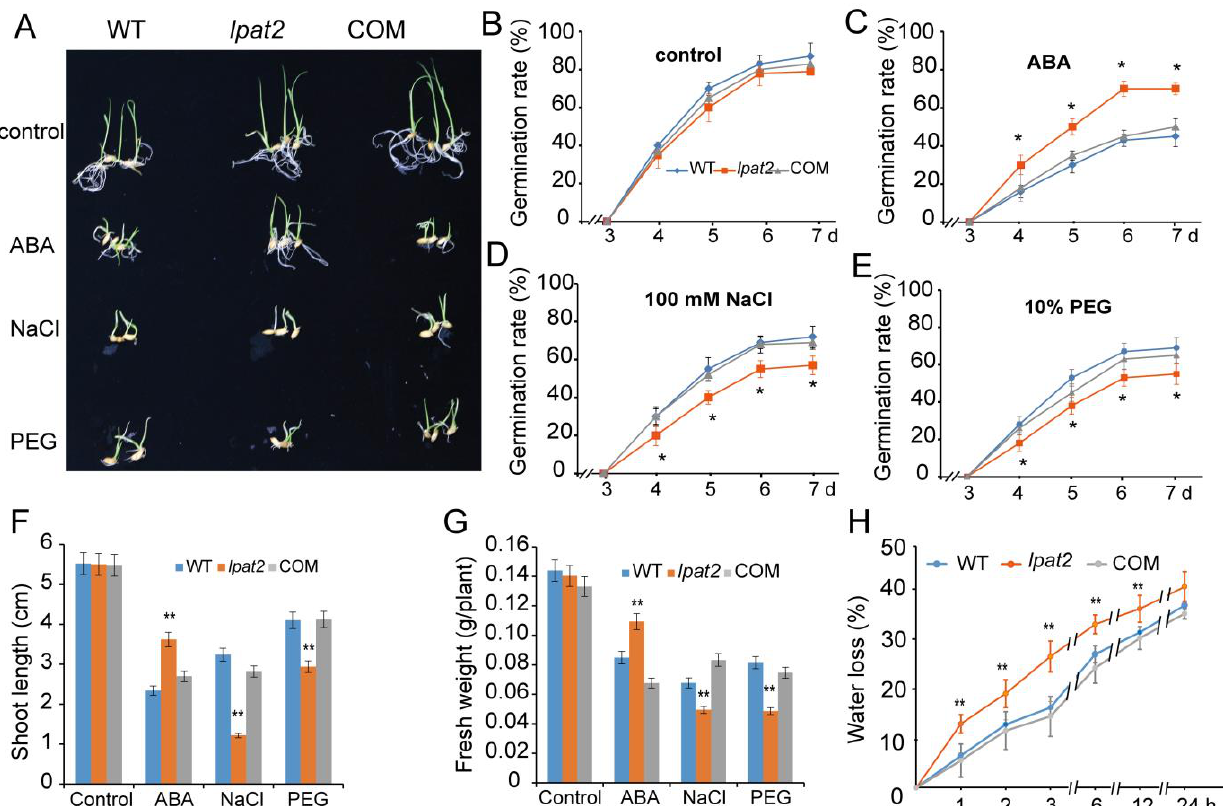
Figure 3. Suppressed LPAT2 led to less sensitivity to ABA and more sensitivity to osmotic stress in seed germination and seedling growth. ( A – E ) The seed germination rate in response to ABA and osmotic stress. The seeds were germinated in various conditions including the control, 10 μ M ABA, 100 mM NaCl, and 10% polyethylene glycol (PEG) treatments. One hundred seeds per genotype were measured in each experiment. Values are means ± SD ( n = 3). ( F , G ) Shoot length and shoot fresh weight of seedlings in response to ABA and osmotic stress. Four-day-old seedlings were transferred to small plastic cups without supplement (control), or with 10 µ M ABA, 100 mM NaCl, and 10% PEG. Values are means ± SD ( n = 15) from one representative of three independent experiments. ( H ) Water loss in leaves of rice plants. Three-week-old plants were removed from soils and left in ambient conditions. The water loss in leaves was expressed as the percentage of decrease in leaf fresh weight. Values are means ± SD ( n = 3) from one of three independent experiments. * and ** indicate significant differences at p < 0.05, and p < 0.01, respectively, compared to the wild type (WT) based on Student’s t test.